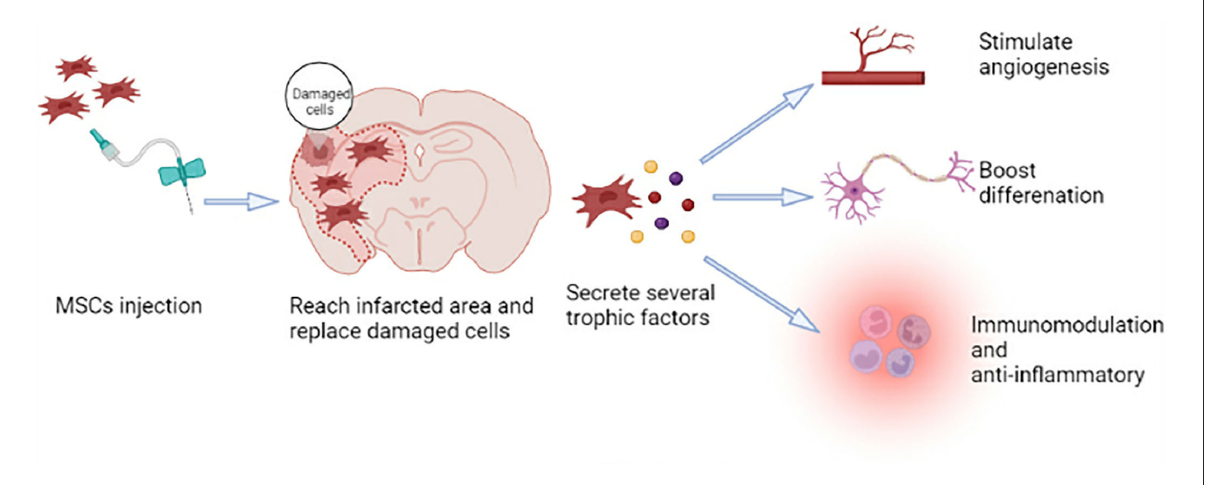
FIGURE1 Mechanism of MSC